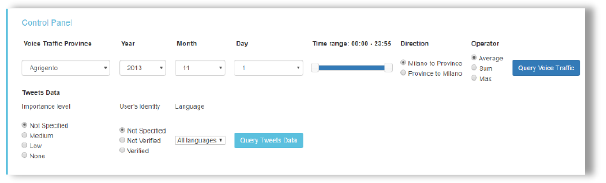
Figure 8. Client’s control